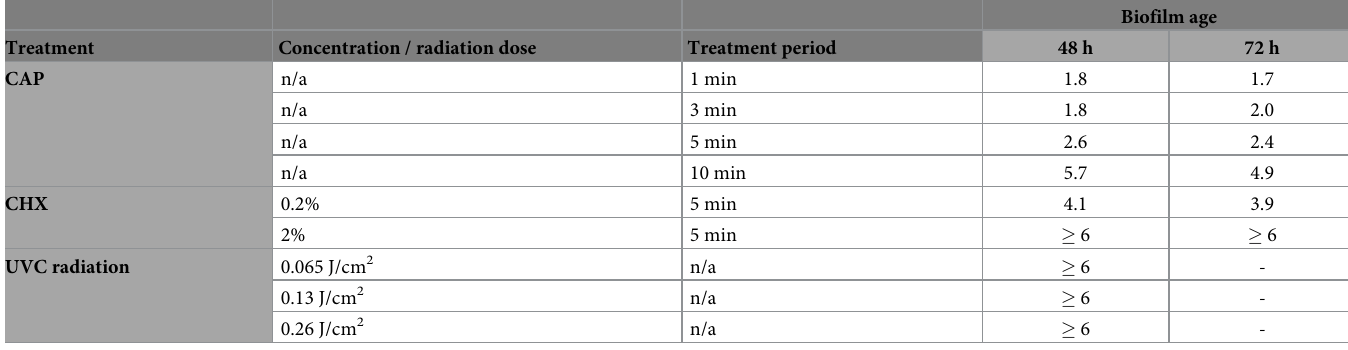
Table 1. Results from antimicrobial assay towards E . faecalis biofilms cultured for 48 h or 72